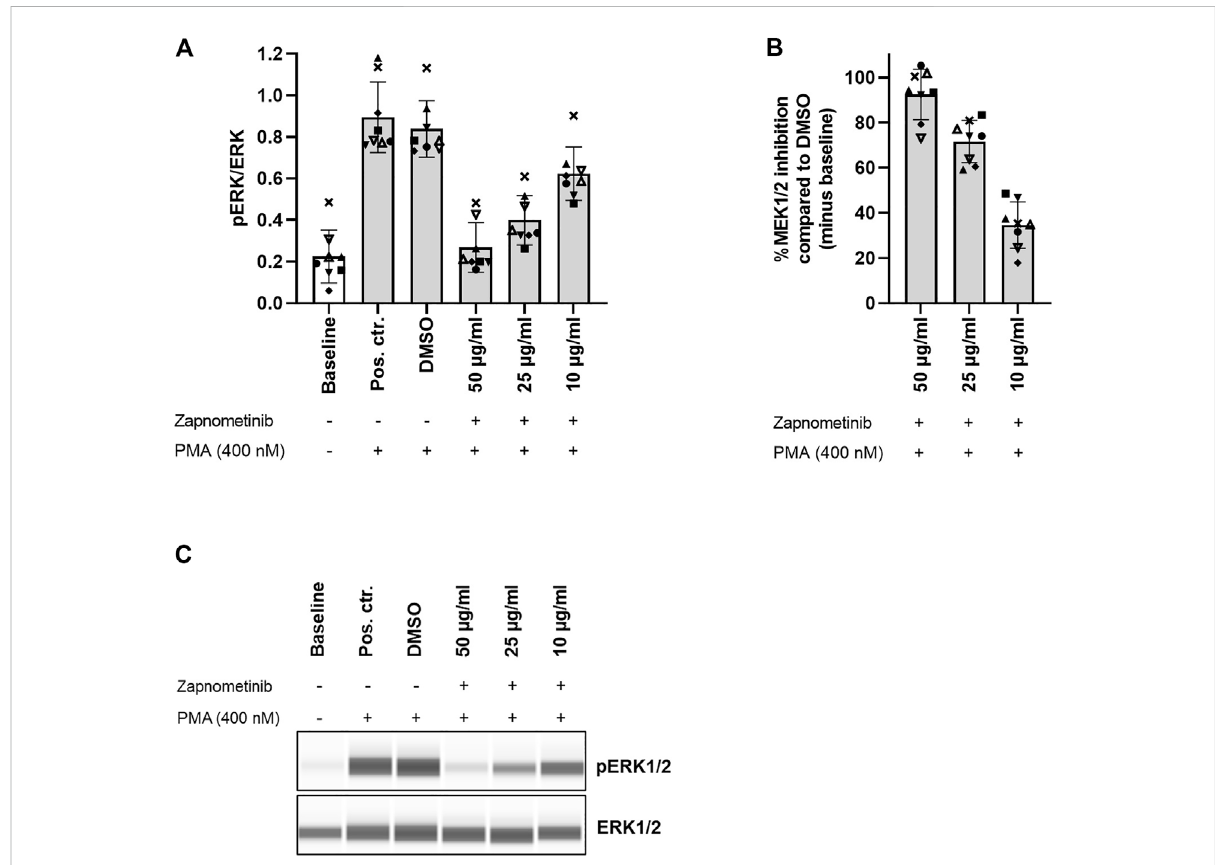
FIGURE 3 Zapnometinib inhibits MEK1/2 in human PBMCs. PBMCs were treated with 10, 25, and 50 μ g/ml zapnometinib, followed by stimulation with PMA. The ERK1/2 phosphorylation status was assessed with the Wes ™ system. Data are displayed as (A) ratio pERK/ERK (ratio of phosphorylated ERK1/2 to total ERK1/2) and (B) %MEK1/2 inhibition compared to DMSO. Data are presented as individual values and mean with standard deviation. Each datapoint represents one blood donor. N = 8 blood donors. (C) Presentation of pERK1/2 and ERK1/2 levels as Western blot-like bands of one representative blood donor included in (A,B) . The Western blot-like band data of all blood donors is shown in the Supplementary